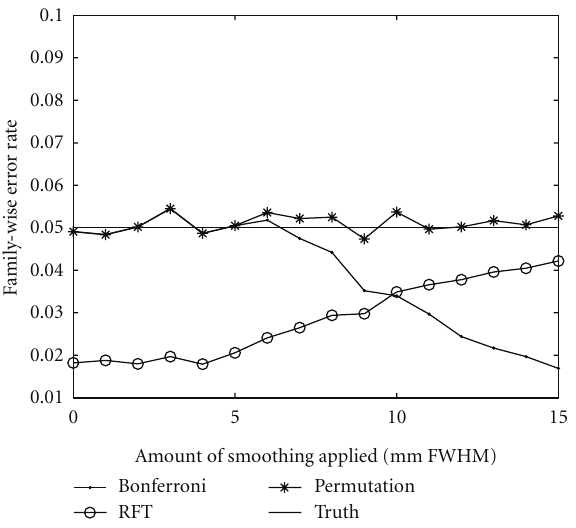
Figure 7: A comparison of family-wise error rates for Gaussian white noise for three di ff erent approaches to calculate an activity threshold, corrected for multiple testing.